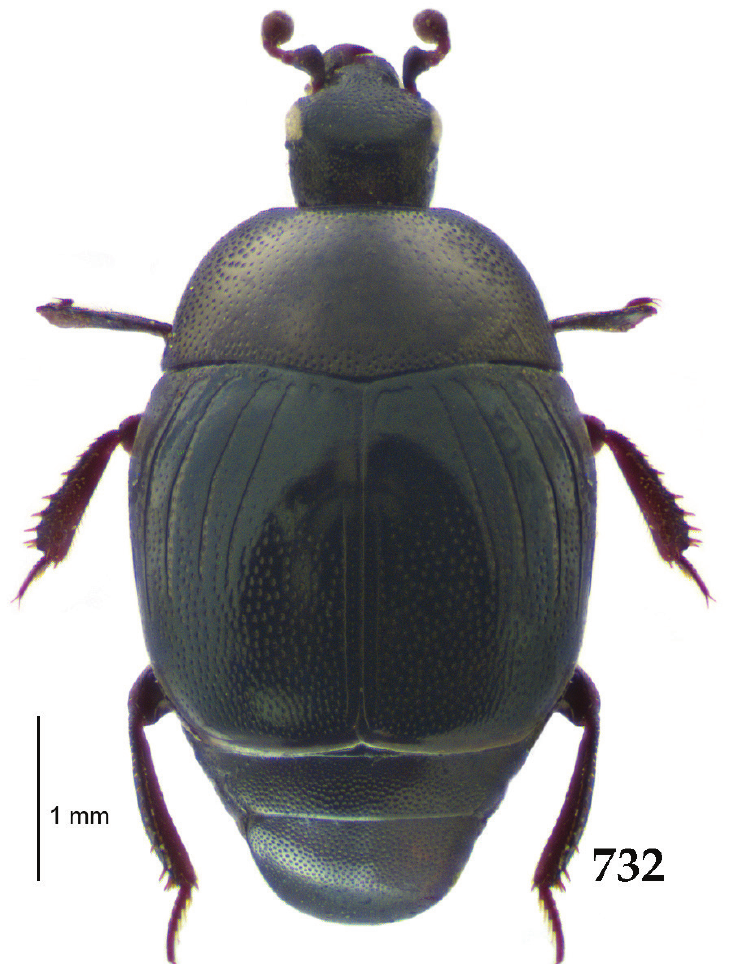
Figure 732. Tomogenius ripicola (Marseul, 1870) habitus, dorsal view. both protarsi and right mesotarsus missing, both metatibiae broken off, glued to the same mounting card as the specimen, with the following labels: “Gnathoncus / ripicola M / Murray Riv. ♂ / illegible” (round pink label, written); followed by: “Murray / Riv.” (pencil-written); followed by: “MUSEUM PARIS / COLL. / DE MARSEUL 1890” (pink label, printed); followed by: “TOMOGENIUS / G. Dahlgren det / RIPICOLA MARS.” (printed-written); followed by: “ ♂ ” (written); followed by: “Tomogenius / ripicola / Mars. / Y. GOMY DET 2004” (written-printed); followed by: “Y. Gomy des. / LECTOTYPE” (red label, printed) (MNHN). Paralectotype, ♂ , designated by Y. Gomy in 2004, side-mounted with genitalia extracted, dismembered and glued to the same mounting card as the specimen, right antennal funicle missing, right